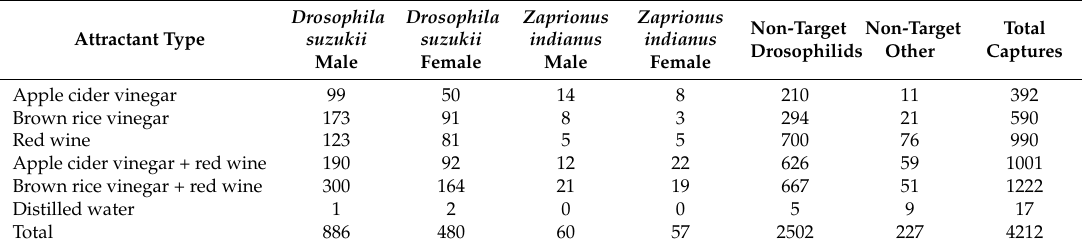
Table 1. Contingency table listing all field captures by attractant type and specimen category. Attractant